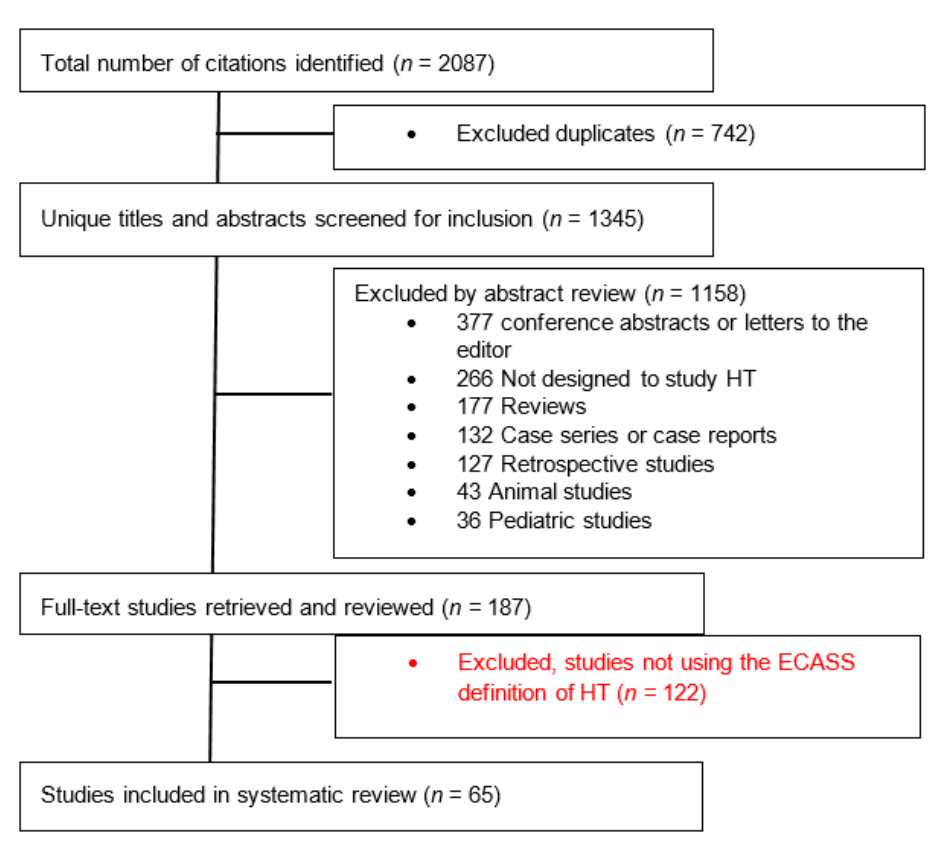
Figure 1. Flow diagram of the study selection process. HT—Hemorrhagic Transformation; ECASS—European Cooperative Acute Stroke Study.